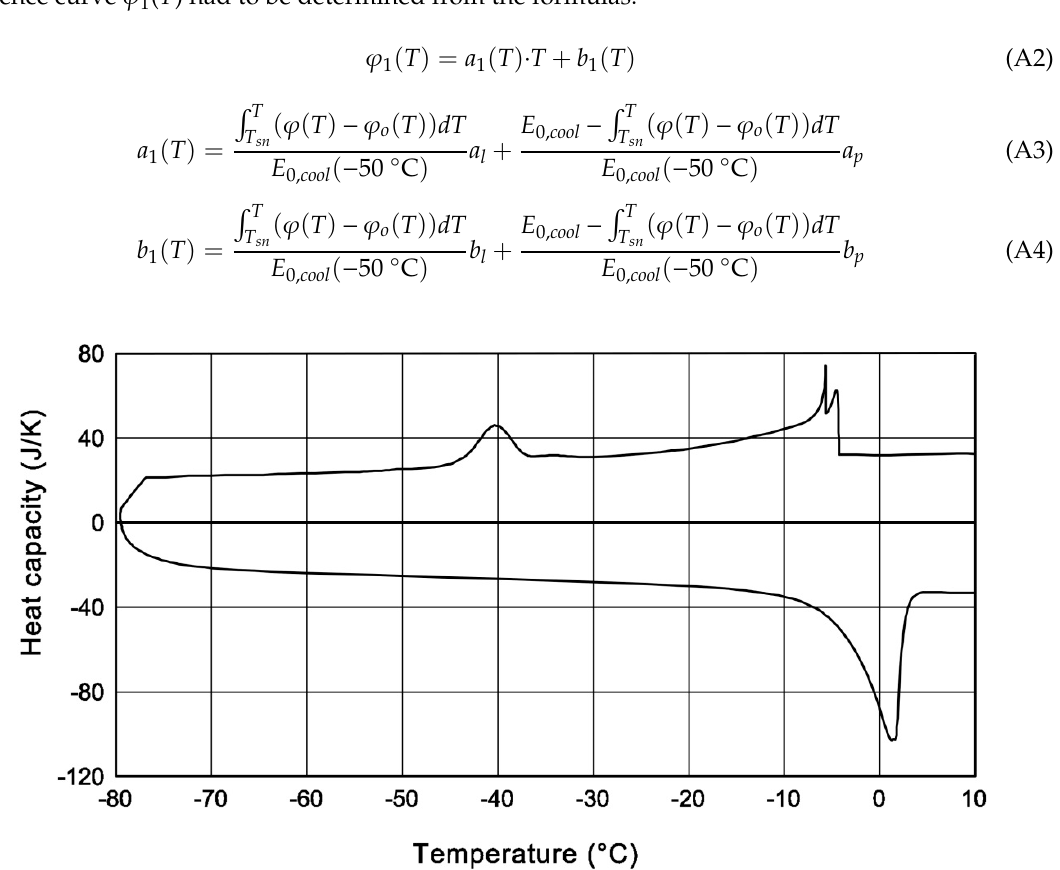
Figure A1. Di ff erence in heat capacity ϕ ( T ) between the pan with the water saturated sample and the Figure A1. Difference in heat capacity φ (T) between the pan with the water saturated sample and the pan with the dry sample of the CEM II / B-V mortar, w / c = 0.53. Materials 2020 , 13 , x FOR PEER REVIEW pan with the dry sample of the CEM II/B ‐ V mortar, w/c = 0.53.